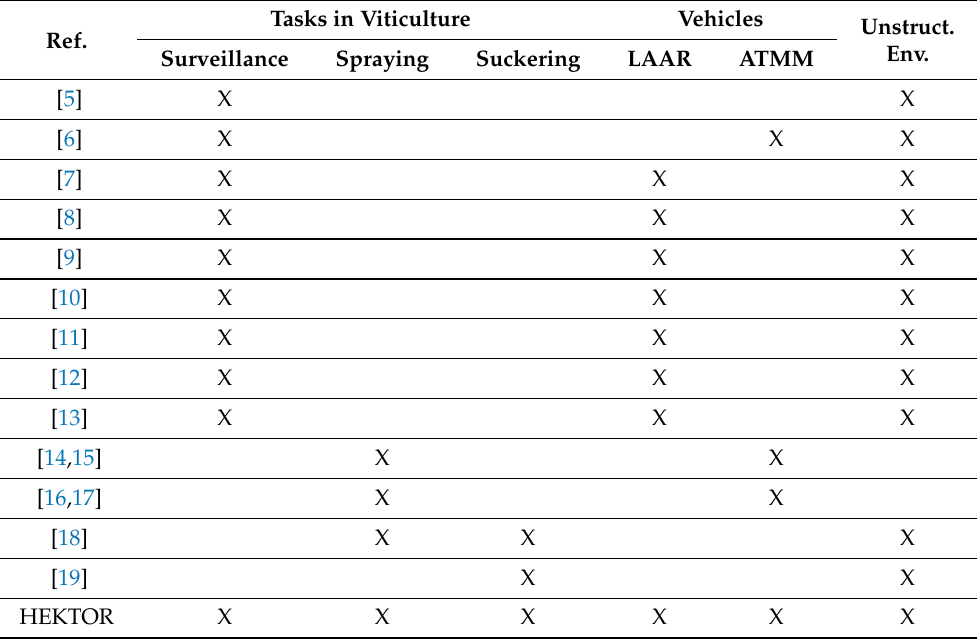
Table 1. Overview of current approaches for vineyard surveillance, spraying and suckering compared to the developed HEKTOR system. Tasks in Viticulture Vehicles Ref.